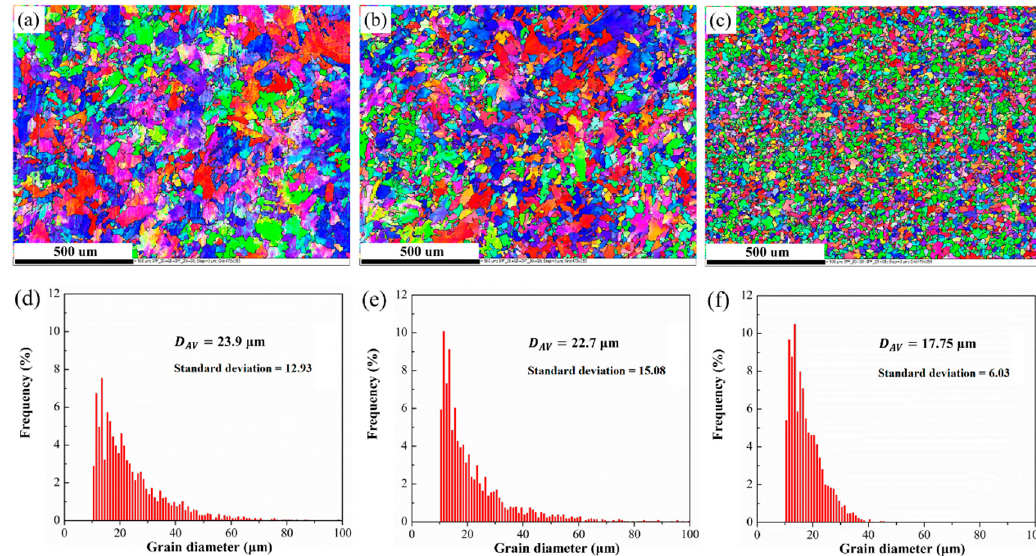
6 of 12 Figure 5. The true stress-true–strain curves at 950 °C and 0.01 s − 1 at different true strains. To further study the effect of the true strain on the DRX characteristics of the tested steel during isothermal compression, EBSD analyses were carried out on the deformed specimens with different true strains (0.105, 0.223 and 0.916). Inverse pole figure maps and grain size distributions for the specimens deformed at 950 °C and 0.01 s − 1 with different true strains are illustrated in Figure 6. Figure 6a–c shows that the microstructures of the deformed specimens were significantly refined with increasing true strain. As shown in Figure 6d–f, when the true strain of the specimen increased from 0.105 to 0.916, the average grain size decreased from 23.90 µm to 17.75 µm, respectively. When the specimen was deformed to a true strain of 0.105, the critical value for DRX was not reached. Therefore, the microstructure of the deformed specimen still contained coarse grains. As the specimen was compressed to a true strain of 0.223, the critical strain for DRX was reached, and a small amount of